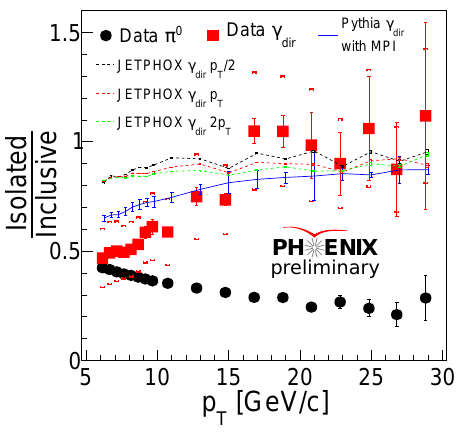
Figure 2: Isolated over inclusive direct photon ratio: bars are statistical uncertainties and square brackets are systematic uncertainties. POWHEG + PYTHIA8 without MPI and JETPHOX NLO pQCD calculations with different renormalization and factoriza- tion scales are also